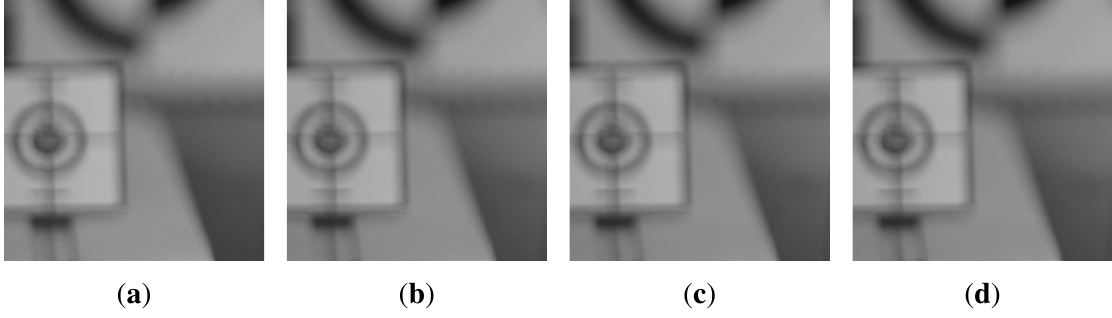
Figure 15. The set of front-focused left-phase images with different illumination : ( a ) the 5 lux image with ISO-3200; ( b ) the 40 lux image with ISO-2000; ( c ) the 70 lux image with ISO-1000; and ( d ) the 100 lux image with ISO-800.